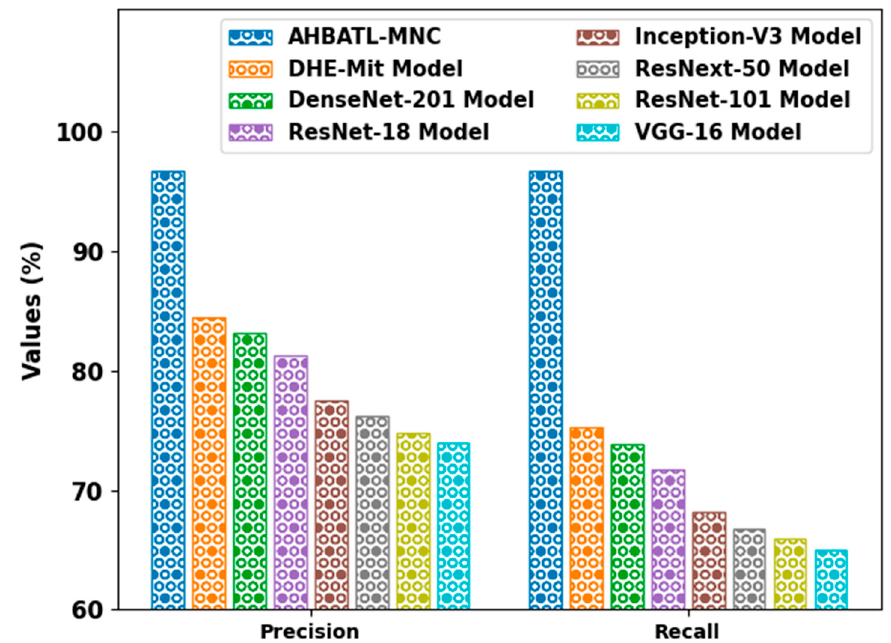
Figure 11. Prec n and Reca l analysis of AHBATL-MNC system compared with other approaches. Table 5 offers a detailed computation time (CT) examination of the proposed model with existing models. The experimental results indicate that the proposed model shows better performance with minimum CT of 12.34 s. On the contrary, the existing models attained increased CT values compared to the AHBATL-MNC model. These results con- firm the improvement of the AHBATL-MNC model over other models. The proposed model accomplished superior performance to other existing techniques due to the hy- perparameter selection of ResNet using Adamax optimizer and AHBA for XGBoost clas- sifier. Table 5. Comparative CT analysis of AHBATL-MNC system with other approaches. Methods